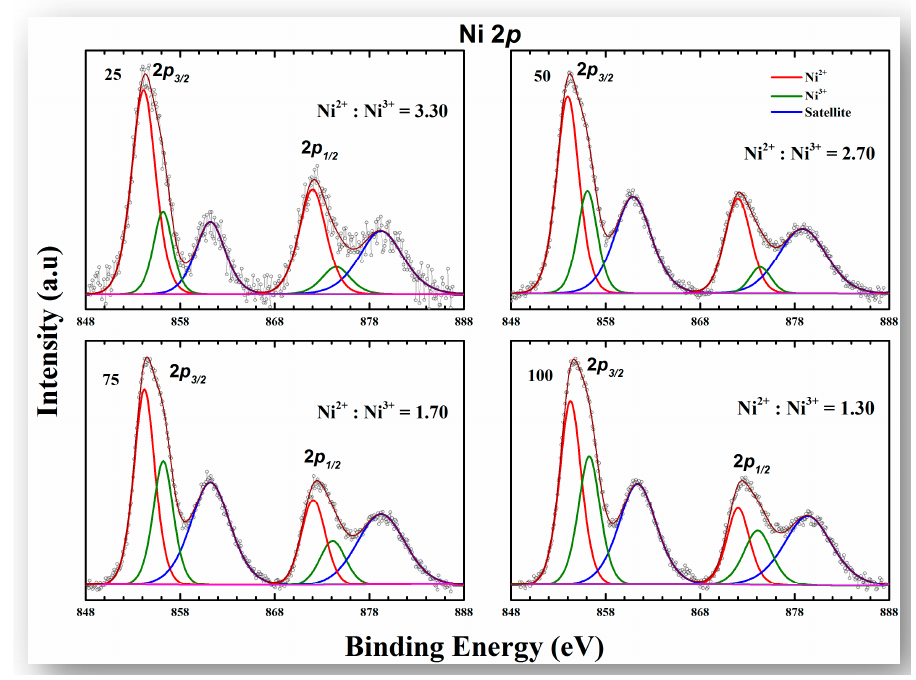
Figure 5. Ni2 p core level spectra.